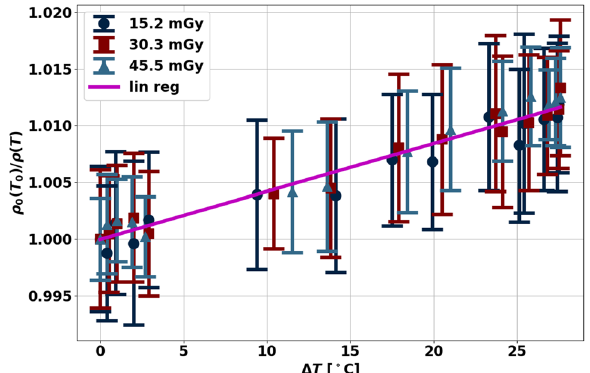
Figure 7. Normalized physical density changes with heating and cooling of ex vivo bovine muscle. The linear relationship between normalized physical density and changes in temperature reflected thermal volumetric expansion, which describes volumetric changes with temperature